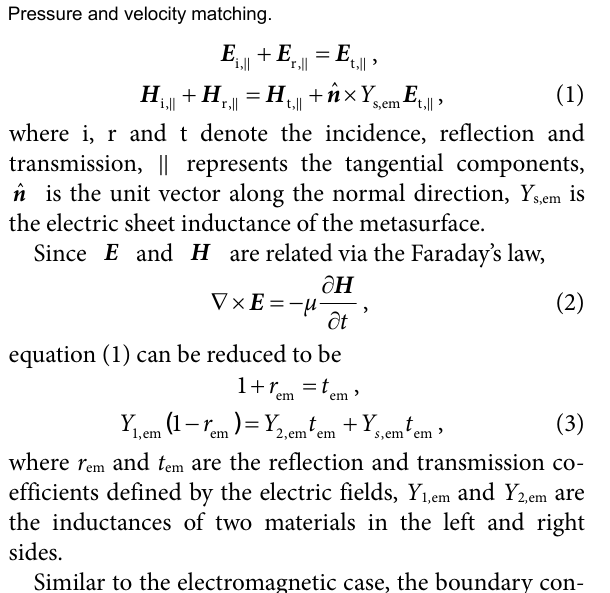
Fig. 1 | Boundary conditions for the electromagnetic and acoustic waves on a thin plate . ( a ) Electric and magnetic fields matching. ( b ) Pressure and velocity